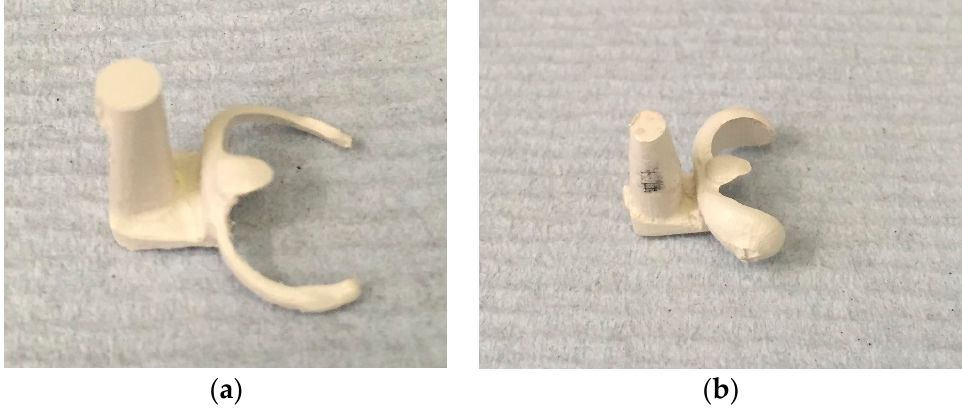
Figure 3 . ( a ) Circumferential PEEK clasp and ( b ) short arm PEEK clasp.